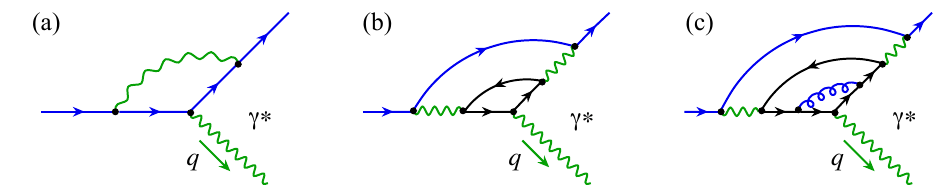
Figure 16 . Sample diagrams, like the virtual diagram in figure 23, responsible for the leading double logarithmic contributions to the coefficient function A of the lepton tensor in eq. (3.25) at (a) LO ( α ), (b) NLO ( α 2 ), and (c) NNLO ( α 2 α s